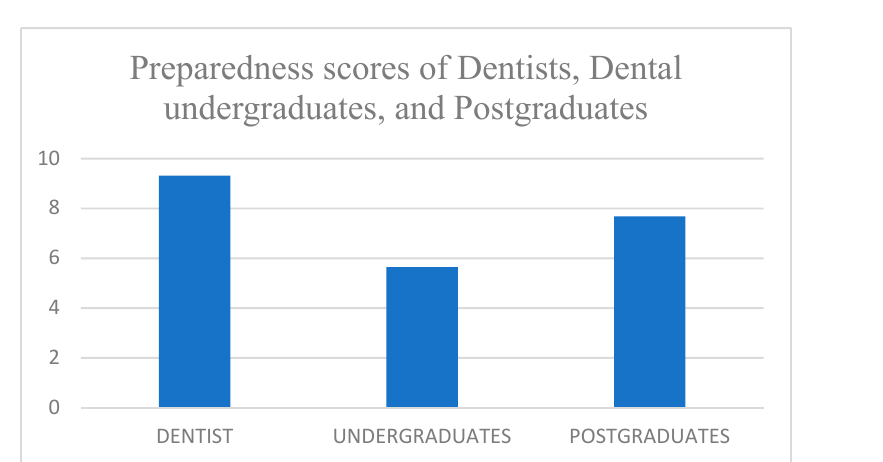
Figure 4. Preparedness scores of dentists, dental undergraduates, and postgraduates.